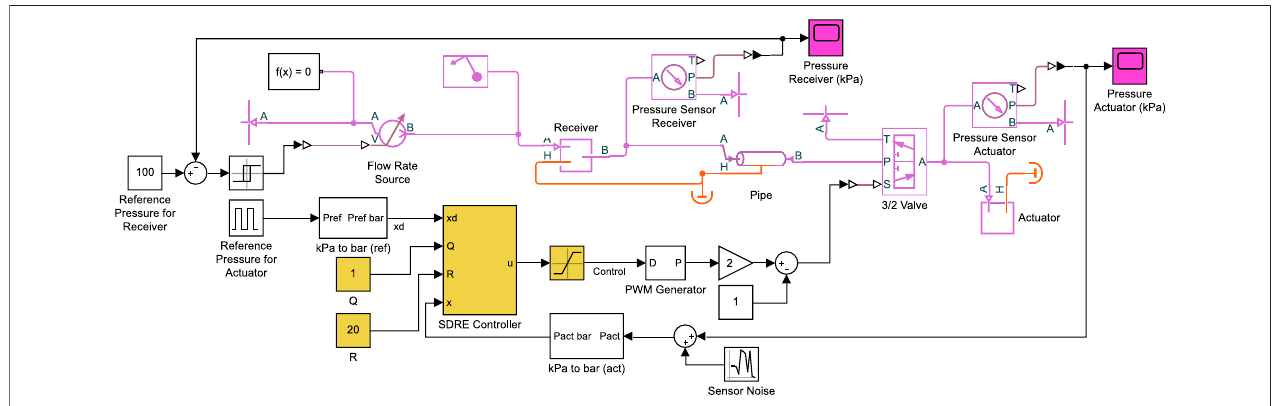
FIGURE2| ModelofpneumaticcontrolsysteminSimulink.Thediaphragmpumpismodeledasavolumetric fl owratesource,thepneumaticlineasapipe,andthe air receiver and actuator as constant volume chambers. Here, the SDRE controller is shown in yellow, where the SDRE controller block contains the implementation of Eqs. 24 and 14 . Equivalent blocks are used for the other controllers. Pressure sensors are added to the actuator and receiver and random sensor noise is added to the pressure measurements.